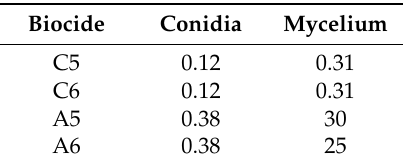
Table 1. Minimal inhibitory concentration (mM) of cationic (C) and neutral (A) gemini surfactants for A. brasiliensis ATCC 16404 conidia and